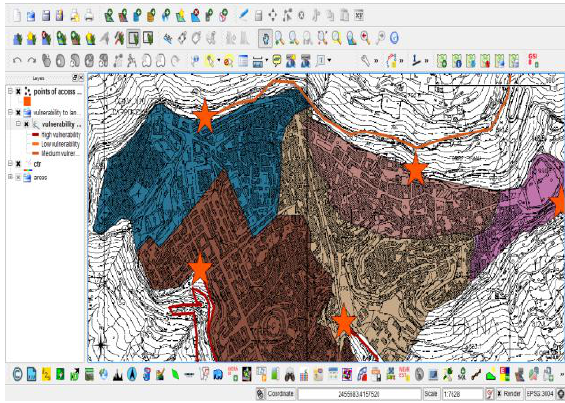
Figure 12. Geological risk of the roads